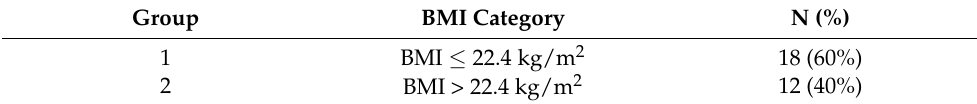
Table 3. Distribution of the sample in two groups based on the BMI according to Shah cutoff. Group